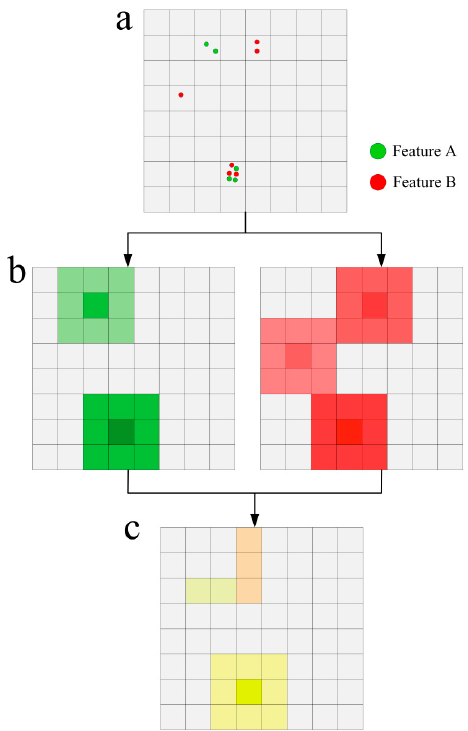
Figure 3. The process of combining multiple kernel density estimation (KDE) surfaces to create a prevalence surface with respect to the pattern of interest: ( a ) original features; ( b ) generating a KDE surface for each feature (the bandwidth is two times the size of the grid cell, and high color scale indicates a large density value); and ( c ) the final co-location prevalence surface (high color scale indicates a large prevalence measure value).